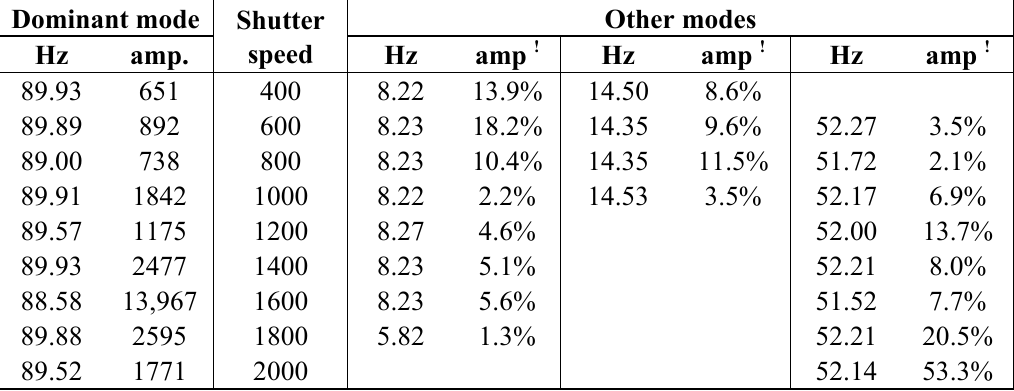
Table 7. Frequency response of the high speed camera with different shutter speed.